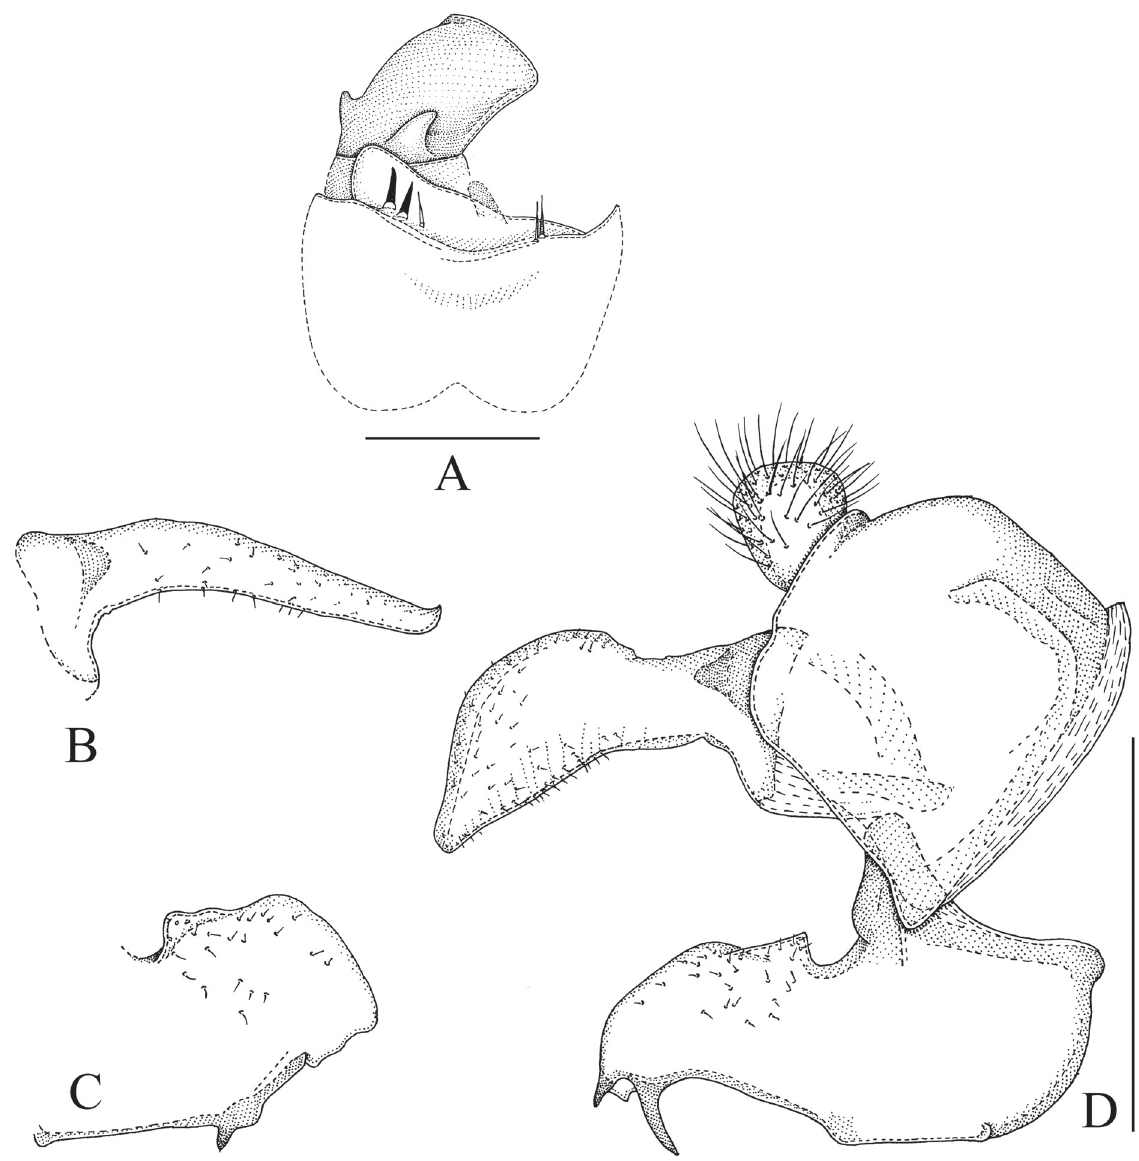
Fig. 44. Sphegina (Asiosphegina) hauseri sp. nov., holotype, ♂ . A . Sterna IV, VI and VII, ventral view. B . Left surstylus, lateral view. C . Left superior lobe, lateral view. D . Genitalia, right side lateral view. Scale bars = 0.5